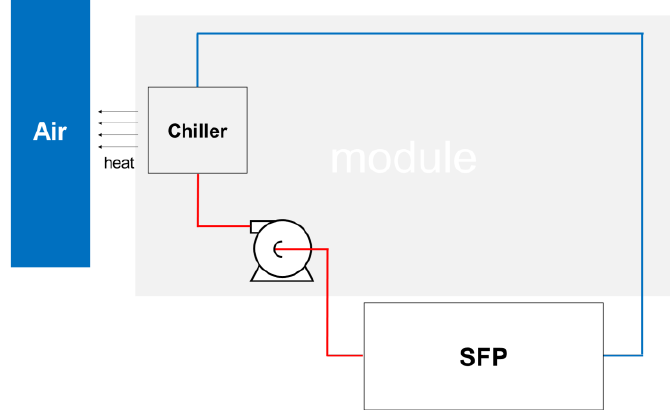
Figure 6. Schematic of a modular direct heat exchange system.